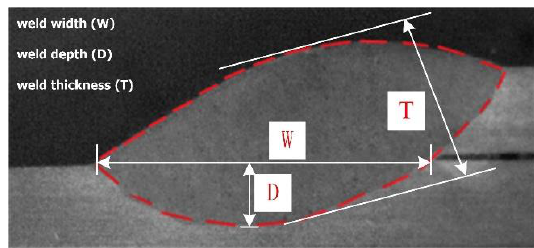
Figure 3. The cross-section of the weld bead. (weld width (W), weld depth (D), weld thickness